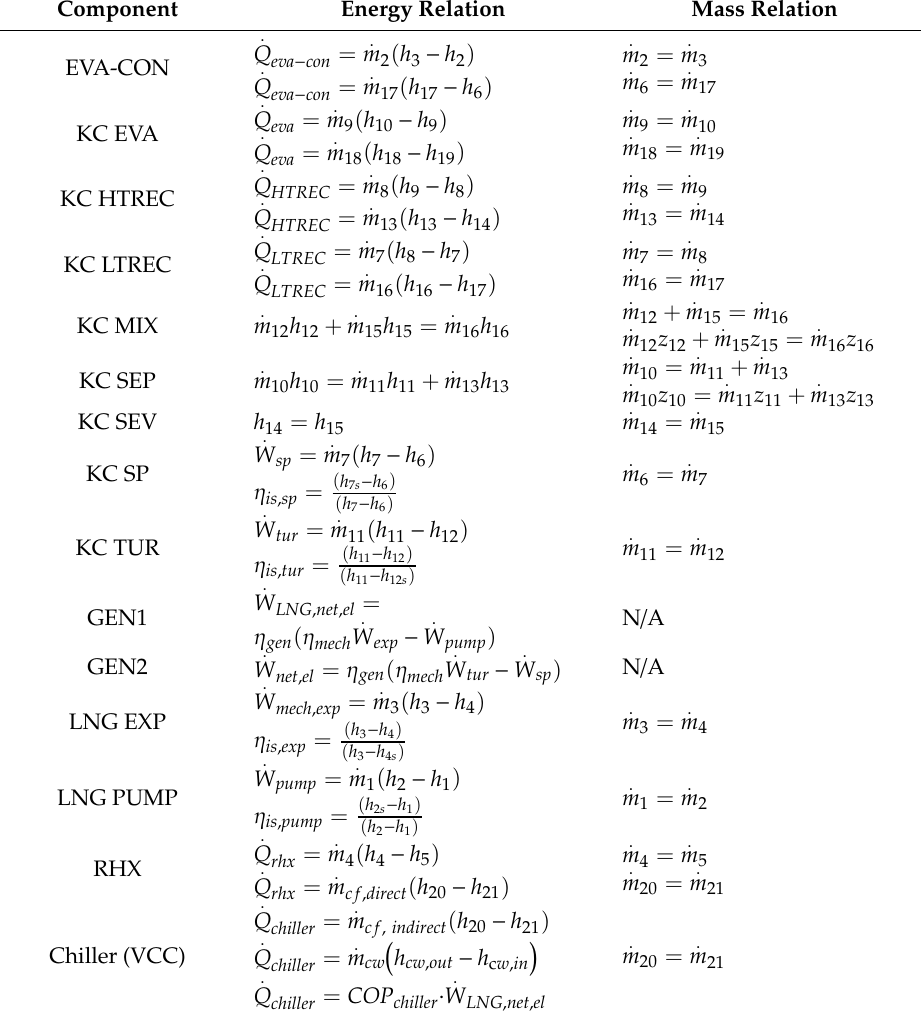
Table A1. Mass and energy relations for the poly-generation system components